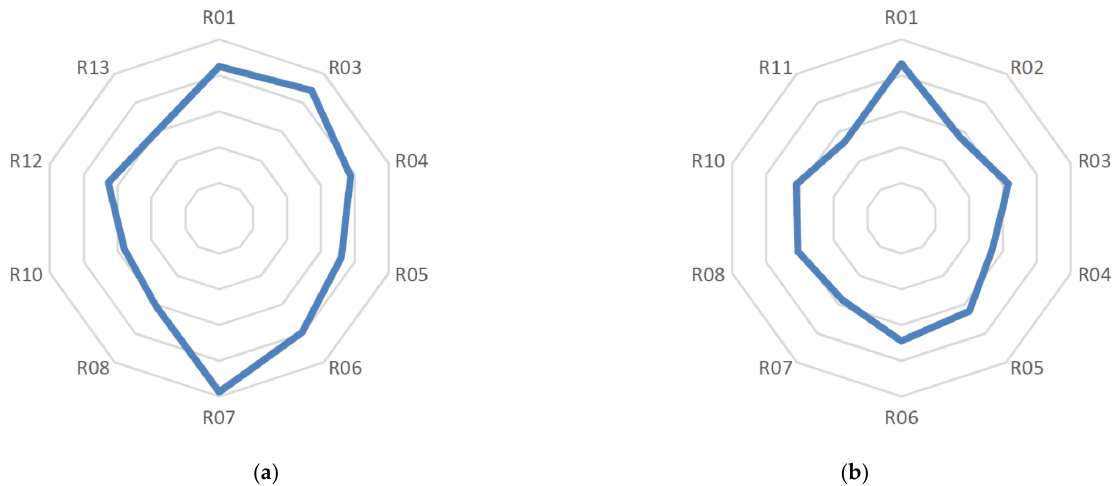
Figure 5. ( a ) Top 10 risks for time objective, ( b ) Top 10 risks for quality objective.